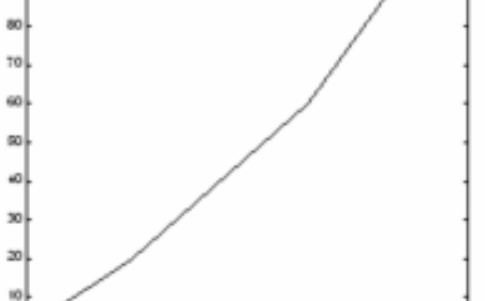
Figure 13: Effect of Literacy on Risk